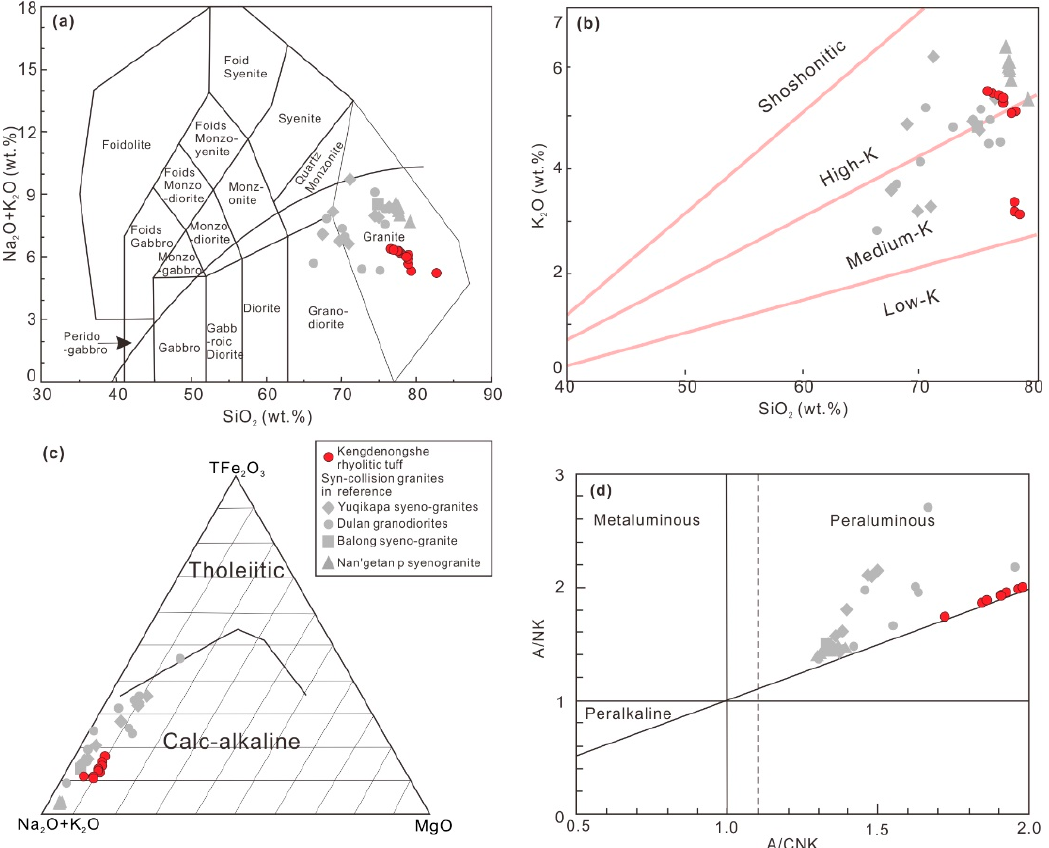
Figure 5. ( a ) Total alkalis versus SiO 2 diagram [28]; ( b ) K 2 O vs. SiO 2 discrimination diagram [29]; ( c ) AFM diagram (after Reference [30]); ( d ) A / CNK versus A / NK diagram [31]. Data of